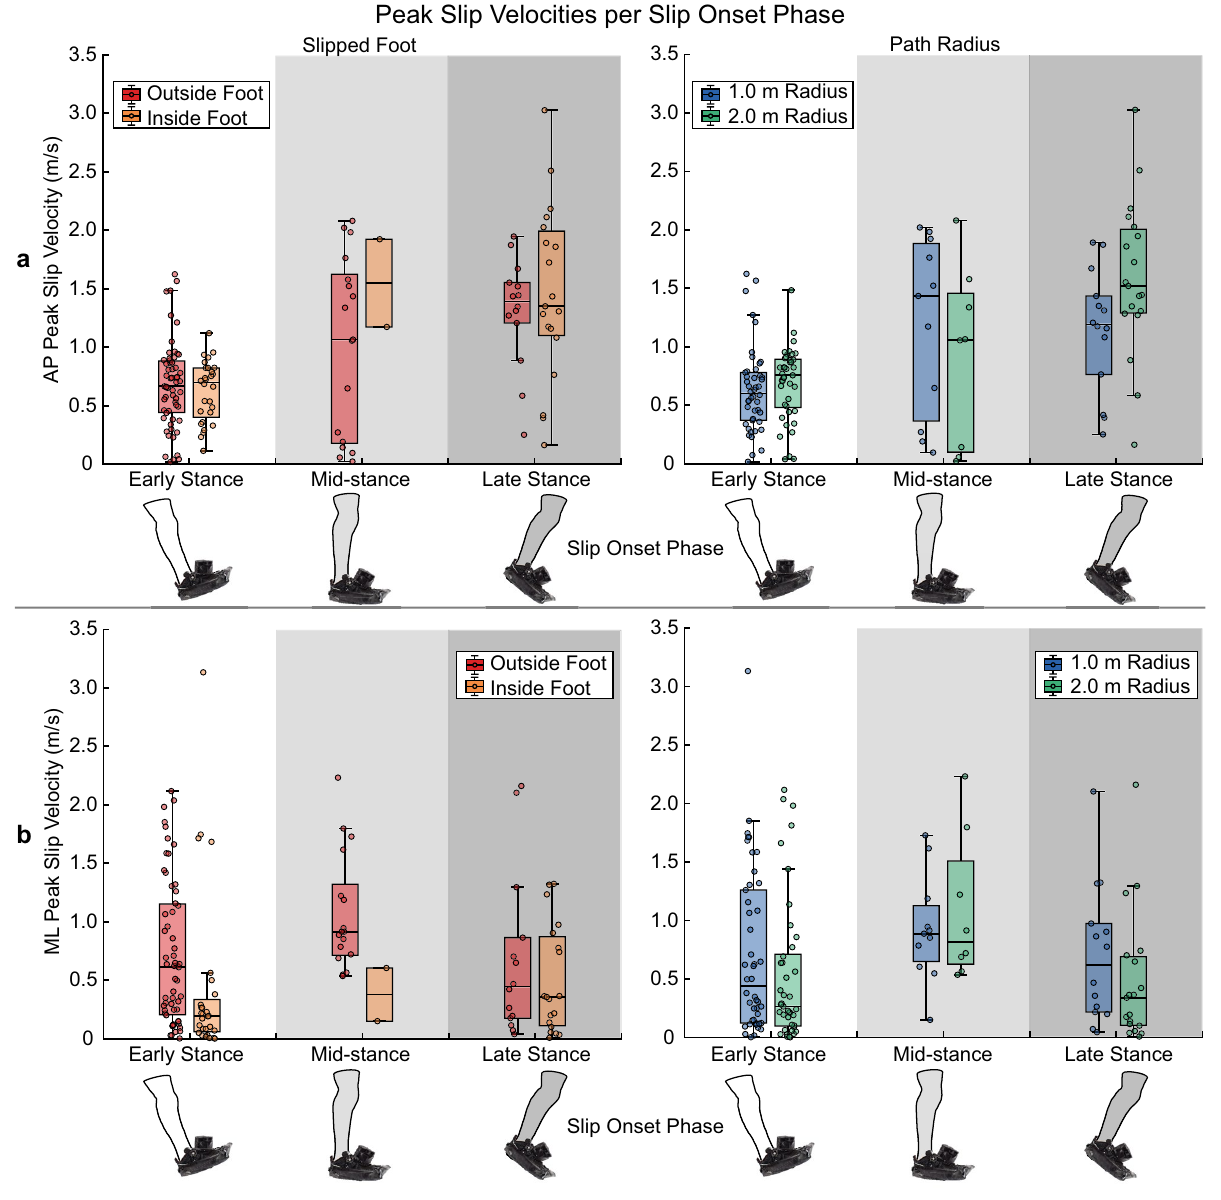
Figure 6. Peak slip velocities in the ( a ) anteroposterior direction and ( b ) mediolateral direction, grouped by slipped foot and path radius. Error bars extend to the most extreme data point within 1.5 * IQR of the first and third quartiles, while outliers fall outside the range of 1.5 * IQR. No outliers were removed prior to conducting the linear mixed-effects model